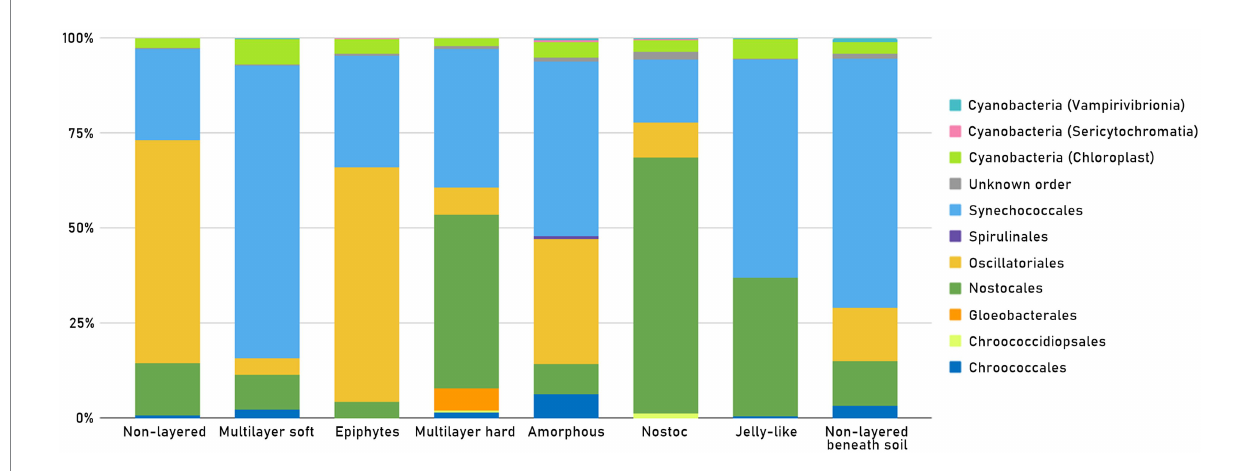
FIGURE 6 Presence of Oxyphotobacteria orders as well as other “Cyanobacteria” (Chloroplasts, Sericytochromatia, Vampirivibrionia) in each mat type, in all 51 samples.